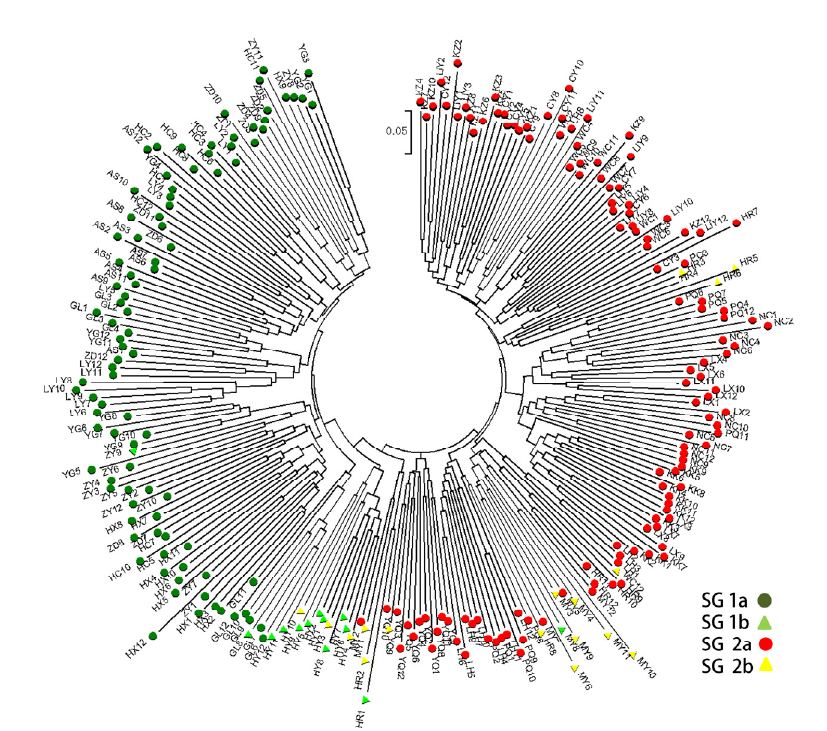
Figure 2. Neighbor-joining trees of 252 wild Siberia apricot